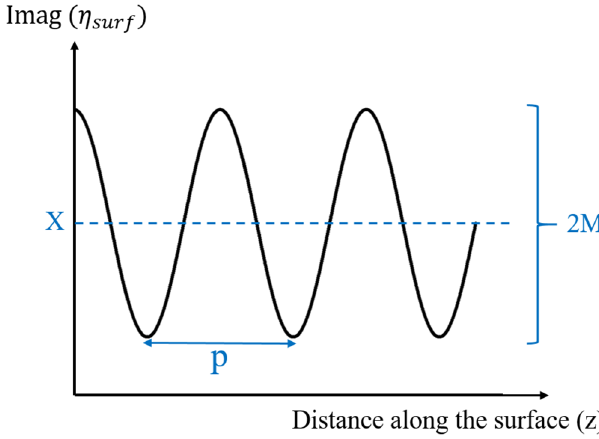
Fig. 1. Plot of the surface reactance of the SMRS.